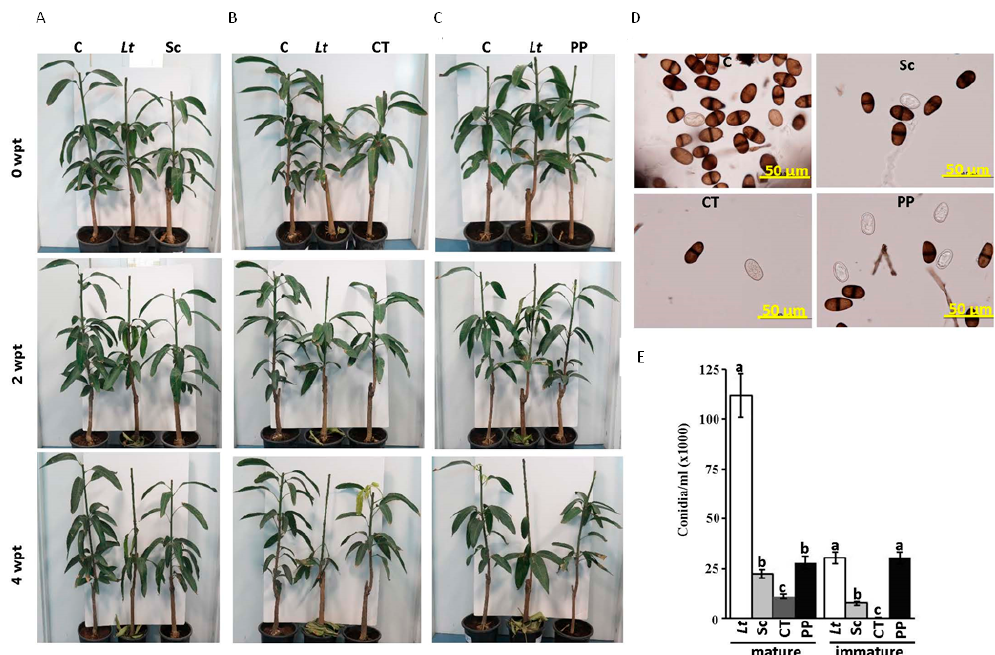
Figure 6. Effect of fungicide treatments on artificially inoculated mango seedlings with L. theobromae in the greenhouse. Fungicidal suppression of dieback disease on mango seedlings using ( A ) Score; ( B ) Cidely ® Top; ( C ) Penthiopyrad ® at 0 (top panel), 2 (middle panel), and 4 (bottom panel) wpt; ( D ) conidia of the pathogen reisolated from affected tissues of fungicide-treated plants; and ( E ) the number of conidia/mL at 4 wpt (6 wpi with L. theobromae ). Seedlings inoculated with L. theobromae at two weeks before the fungicide treatment. Values with different letters are significantly different from each other at p < 0.05. C, control (non-inoculated seedling); Lt , L. theobromae -inoculated seedling; Sc, Score ® ; CT, Cidely ® Top; PP, Penthiopyrad ® .